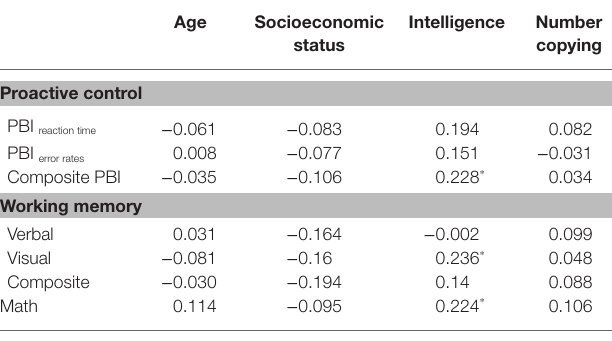
TABLE 2 | The correlations of age, socioeconomic status, and fluid intelligence with key study variables.